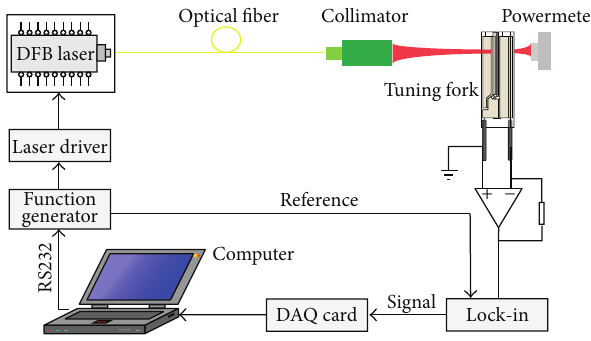
Figure 1: Schematic of the experimental setup.